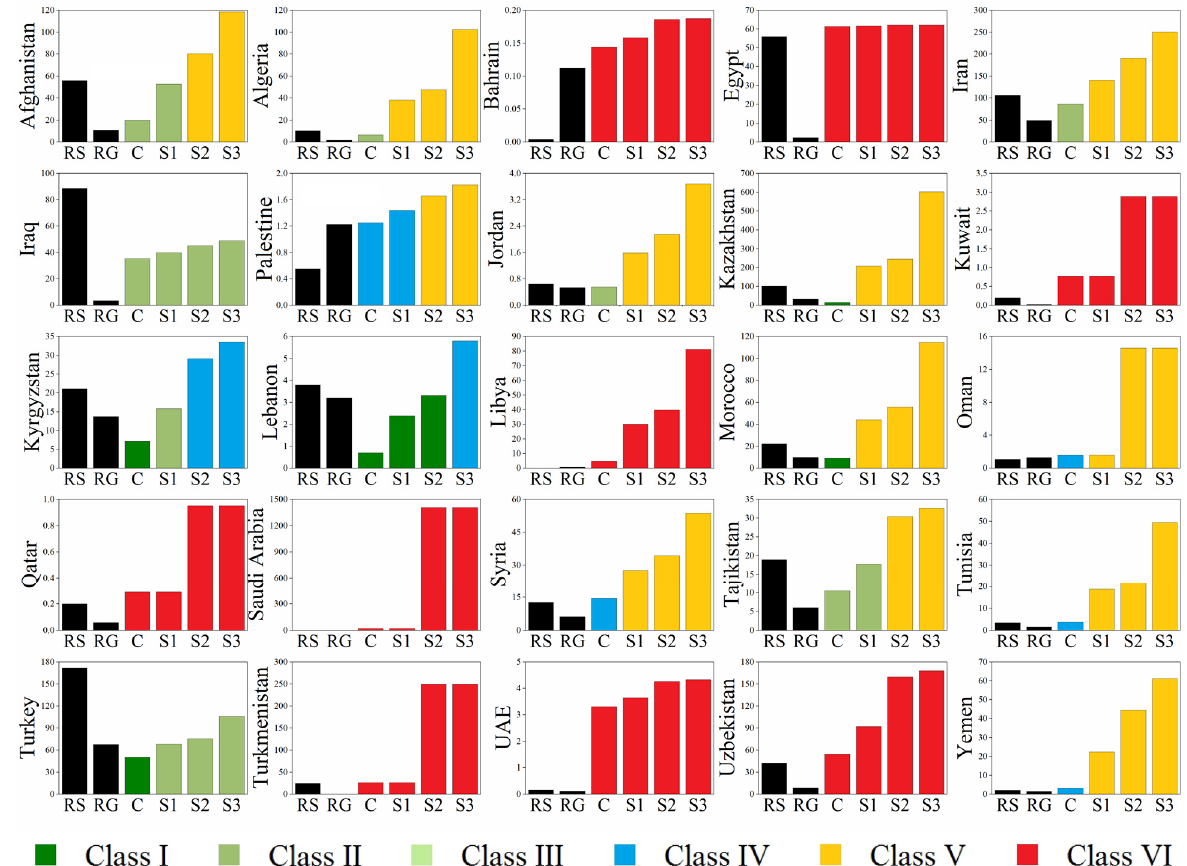
Figure 1. The current surface and groundwater renewability rate in MENA and Central Asian countries (km 3 ). The figure also shows the current agricultural water demand and the three farming scenarios water demand for each country. R S : renewable surface water (km 3 ), R G : renewable groundwater (km 3 ), C: current agricultural water consumption (km 3 ), S 1 , S 2 , and S 3 are scenarios 1, 2, and 3 water demand in (km 3 ), respectively.